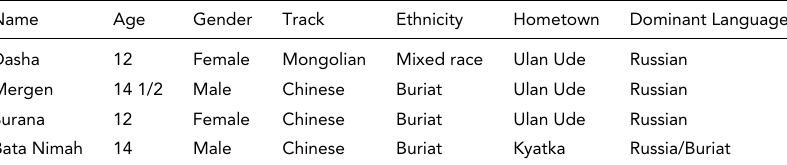
Focal Children/Participants